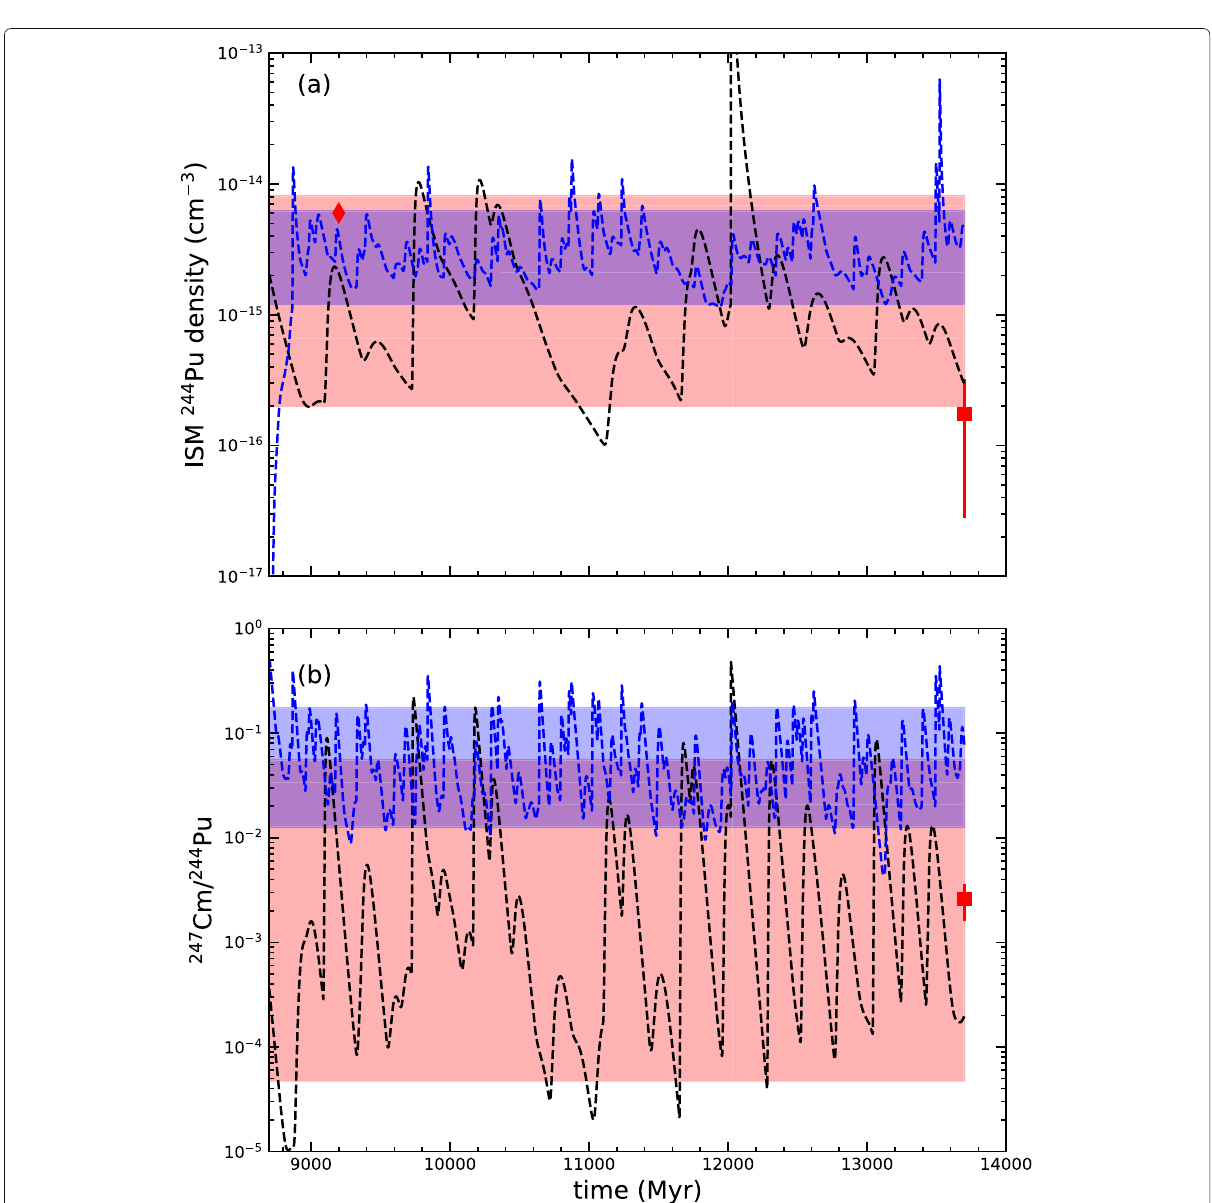
Fig. 6 a Evolution of 244 Pu ISM density for r -process sources with rates of 10 Myr − 1 (red) and 500 Myr − 1 (blue). The shaded regions show the corresponding 90 percentile range. The estimated 244 Pu ISM in the ESS (red diamond) is shown along with the estimated local ISM density over the last 25 Myr estimated from earth’s crust (red square) [45]. b Evolution of the corresponding 247 Cm/ 244 Pu ratio along with the measured ratio in the ESS (red square). The shaded regions correspond to the 90 percentile